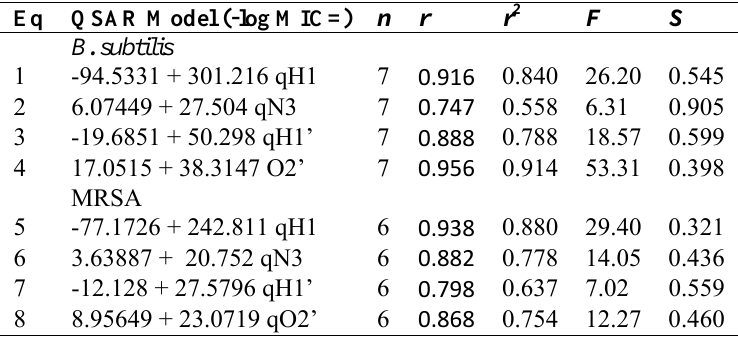
Table 5. Linear regression analysis and quality of correlation for modeling the antimicrobial activity of BZS. –log MIC = a + bq